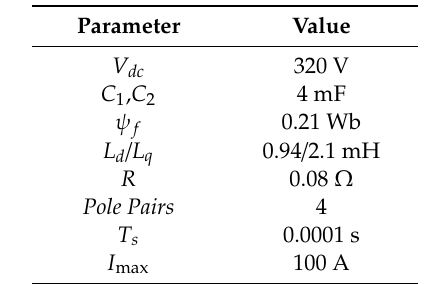
Table 1. Parameters of the IPMSM.